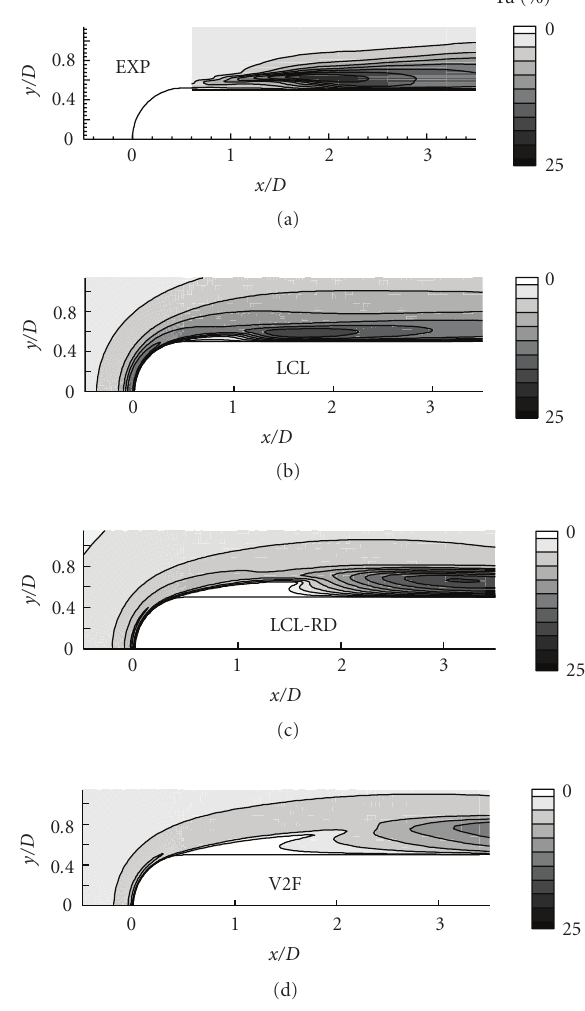
Figure 2: T3L 3 : turbulence